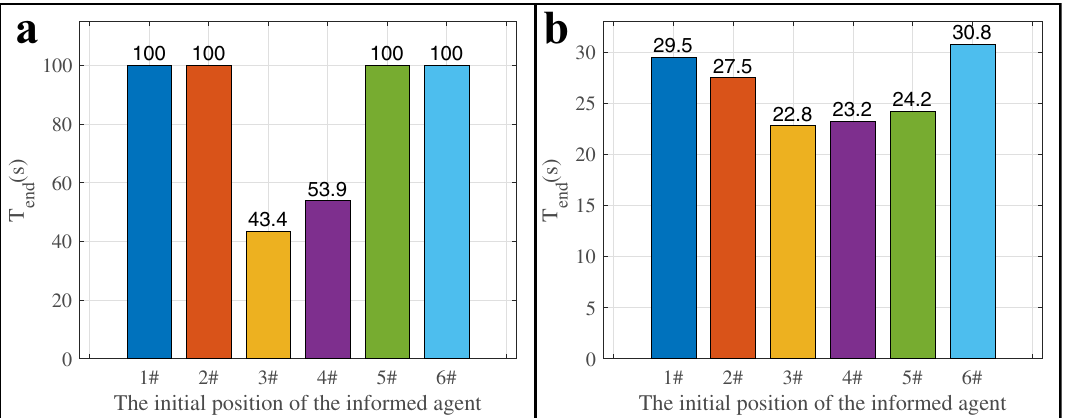
Fig. 8 Time it takes for the drone swarm to traverse the typical scenario in simulation. a The task completion time of the non-AGDS flocking algorithm when the informed agent is in different positions. b The task completion time of the AGDS flocking algorithm when the informed agent is in different positions